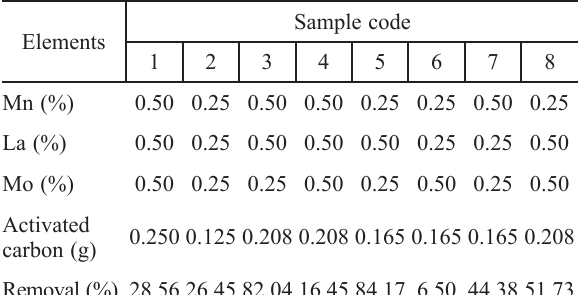
Table 2 – Dye removal efficiency in eight different synthe- sized nanocomposites with different proportions of Mo, Mn and la, RR 198 60 mg l –1 , irradiation time: 60 min, pH: 7, photo